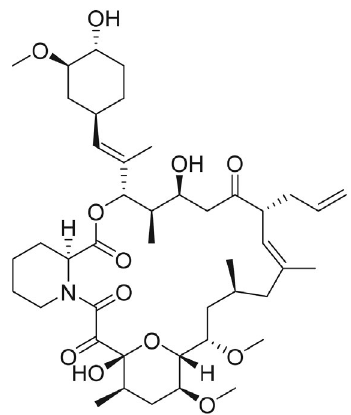
Figure 1. Chemical structure of tacrolimus